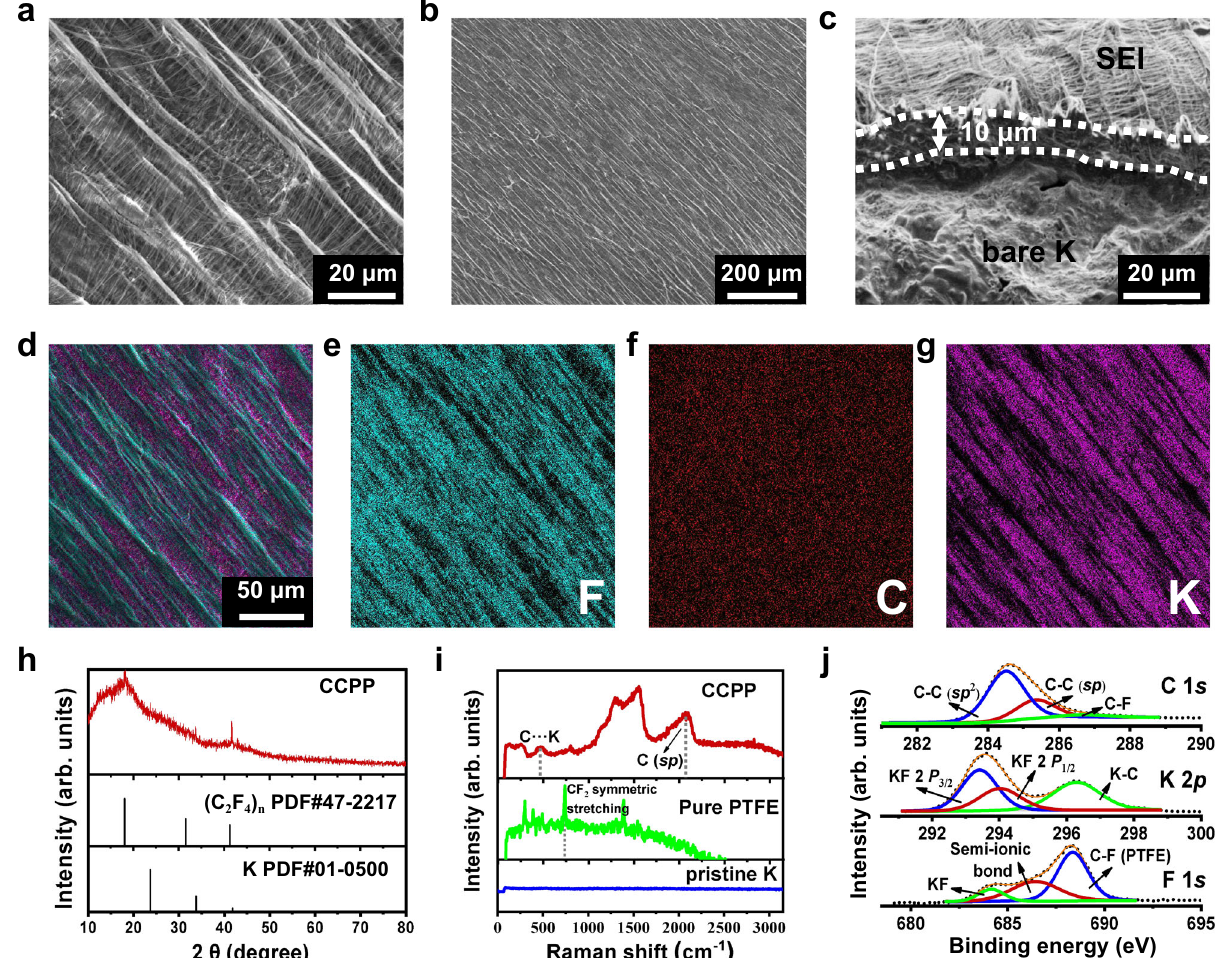
Fig. 2 Morphologies and composition characterizations of CCPP. a , b Top views of CCPP by SEM. c Cross-sectional view of CCPP, the thickness of the SEI is ~10 μ m. d – g The corresponding elemental mappings of CCPP. h XRD pattern of CCPP. i Raman spectrums of CCPP, pristine K, and Pure PTFE. j C 1 s , K 2 p , and F 1 s XPS spectra of CCPP. Source data are provided as a Source Data fi